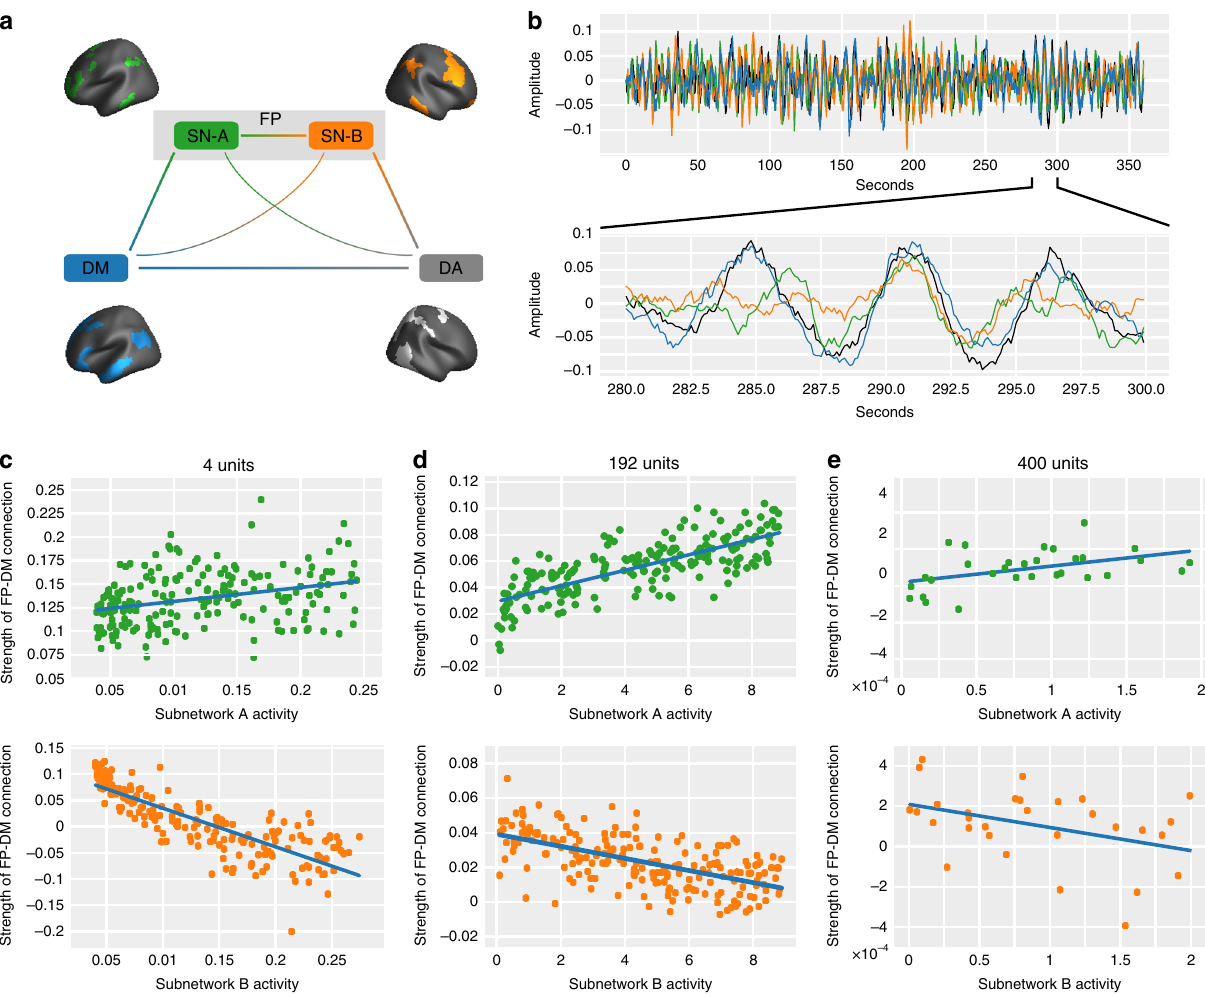
Fig. 3 A simpli fi ed model for studying the relationships between brain system activity and connectivity. a We constructed a dynamical model of a 4-, 192-, and 400-oscillator representation of either the four systems (default mode, DM; frontoparietal subnetworks, SN-A & SN-B; and dorsal attention, DA) of interest (4- and 192-oscillator systems), or of the entire brain (400-oscillator system). Here, we show a representation of this oscillator network consisting of the frontoparietal subnetwork (A), the frontoparietal subnetwork (B), the default mode system, and the dorsal attention system. The remaining oscillators are not shown here representing all other regions of the brain used in the 400-oscillator model. b The network dynamics were integrated out to a total time of 6 min, consistent with the length of the empirical n-back scan. c Using four oscillators, increasing the amplitude of subnetwork (A) activity, while keeping all others equal, caused an increase in the functional connectivity between the frontoparietal and default mode units (Pearson correlation coef fi cient between unit timeseries: r = 0.396, p = 0.001), while increasing the amplitude of subnetwork (B) activity caused a decrease in the functional connectivity between the frontoparietal and default mode units (Pearson correlation coef fi cient between unit timeseries: r = − 0.866, p < 0.0001). d Using 192 oscillators, increasing the amplitude of subnetwork (A) activity caused an increase in the functional connectivity between the frontoparietal and default mode units ( r = 0.753, p = 0.001), while increasing the amplitude of subnetwork (B) activity caused a decrease in the functional connectivity between the frontoparietal and default mode units ( r = − 0.599, p < 0.0001). e Using 400 oscillators, increasing the amplitude of subnetwork (A) activity caused an increase in the functional connectivity between the frontoparietal and default mode units ( r = 0.453, p = 0.011), while increasing the amplitude of subnetwork (B) activity caused a decrease in the functional connectivity between the frontoparietal and default mode units ( r = − 0.394, p = 0.031). Note that panel ( e ) contains the results of 30 simulations, in contrast to the 200 simulations depicted in panels c and d ; this difference is due to the marked increase in computational burden in the 400-oscillator